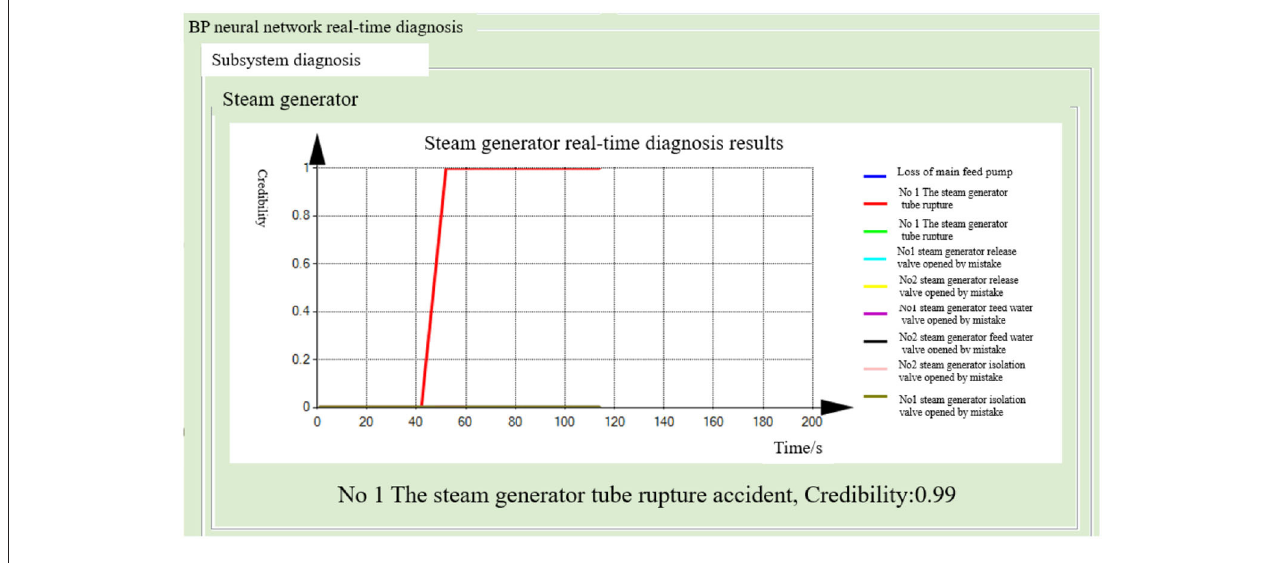
FIGURE 12 | Real-time diagnosis result of steam generator (BP neural network method).